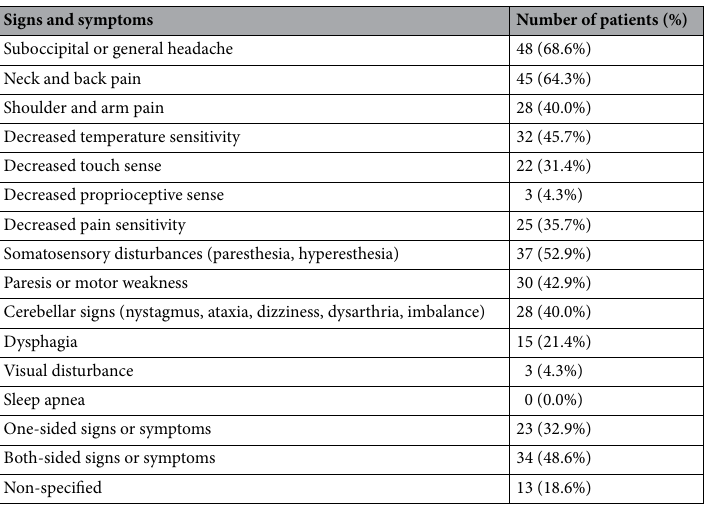
Table 1. Preoperative signs and symptoms in 70 patients with symptomatic Chiari malformation type